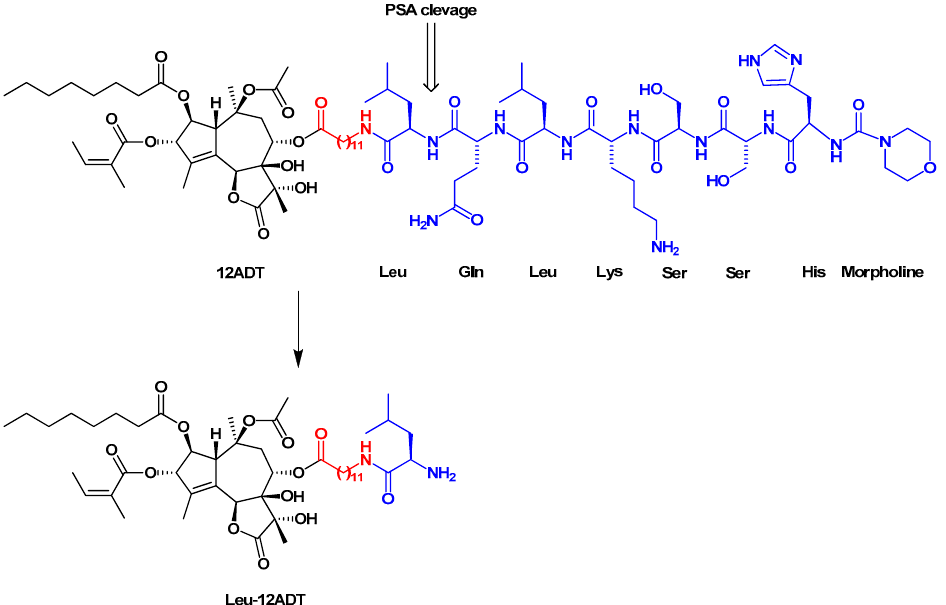
Figure 3. The structure of the G115 prodrug and the product of its PSA cleavage, Leu-12ADT. The linker is marked in red.